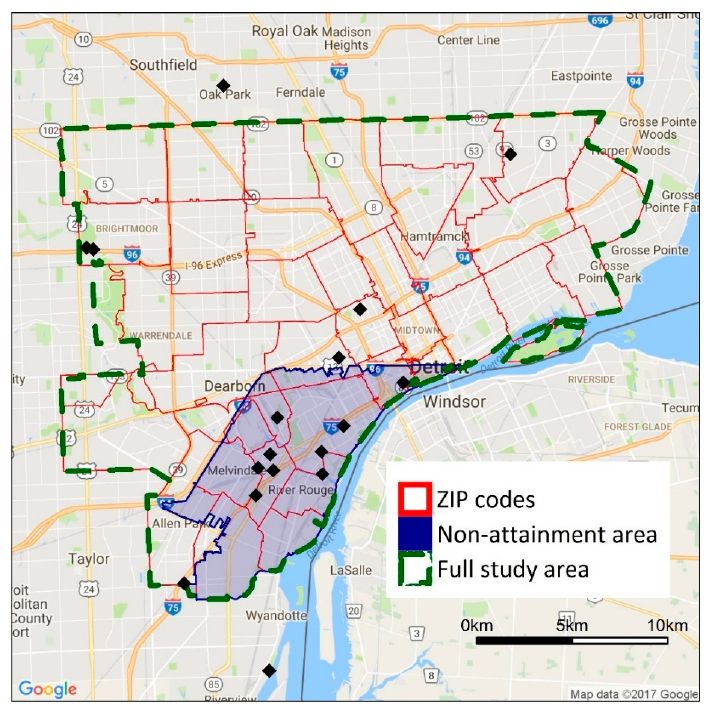
Figure 1. Map showing the full study area boundary and the study boundaries used in the sensitivity analyses. Black diamonds show the location of ambient air quality monitors in the area. The shaded area has been classified as non ‐ attainment with the SO 2 national ambient air quality standard (NAAQS).